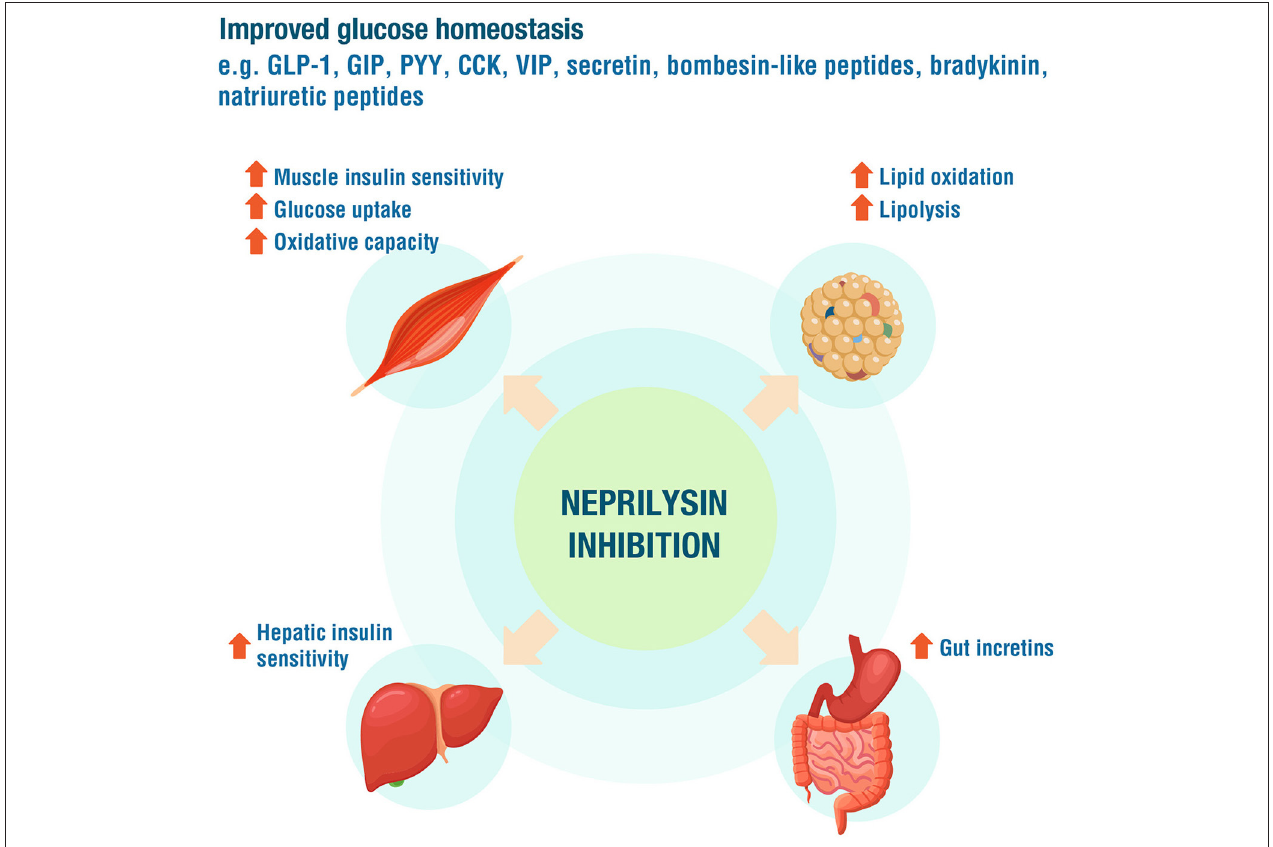
FIGURE 7 | The role of neprilysin inhibition in glucose homeostasis. GLP-1, glucagon-like peptide 1; GIP, glucose-dependent insulinotropic peptide; PYY, peptide YY; CCK, cholecystokinin; VIP, vasoactive intestinal polypeptide. Adapted from Esser and Zraika